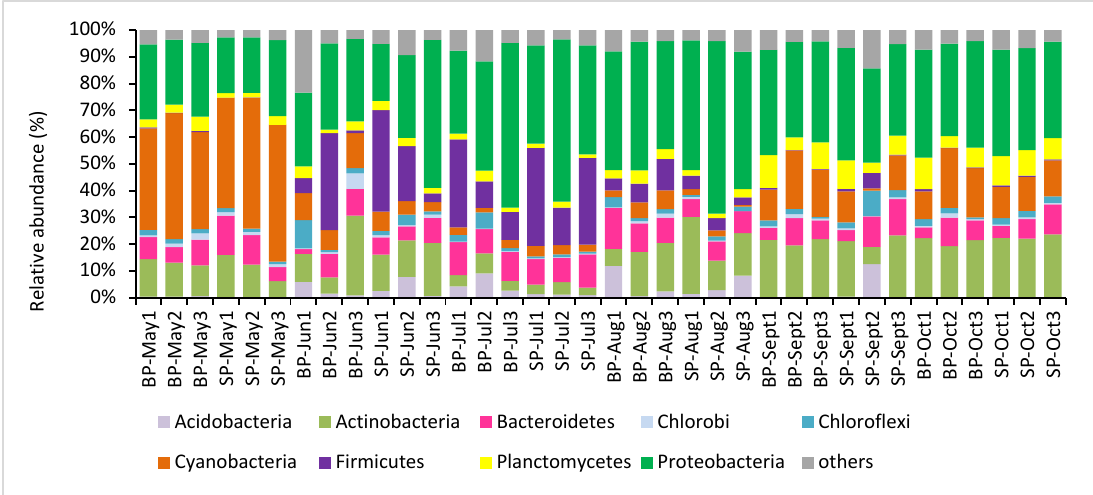
Figure 2. Relative abundance of the dominant bacterial phyla for pond water in different months. BP, large area pond; SP, small area pond; May–Oct. indicate sampling time; 1, 2, and 3 represent three duplicate ponds.